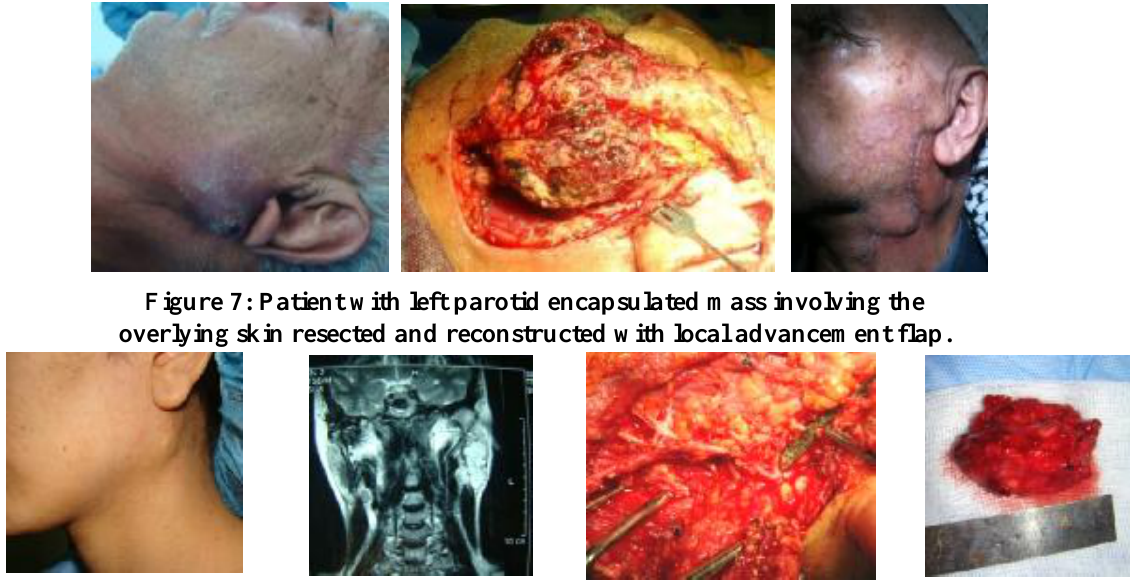
Figure 8: A relatively small volume malignancy of the parotid gland in a 35 years old female with static and dynamic facial nerve dysfunction. Total parotidectomy with facial nerve preservation was